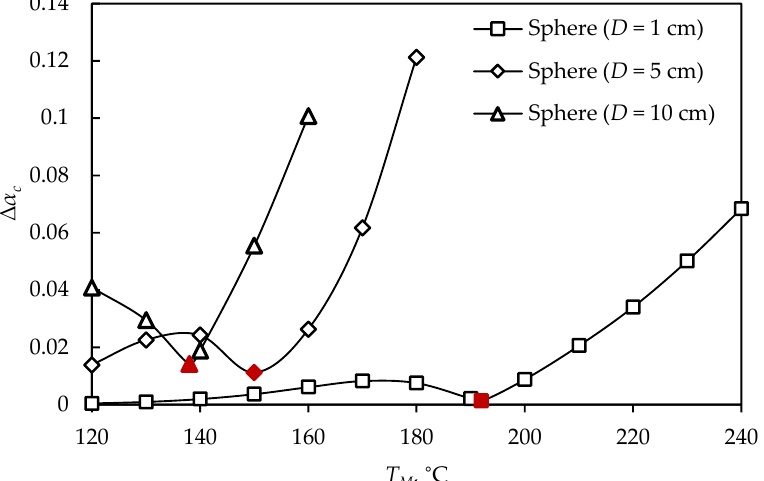
Figure 9. The difference between the maximal and minimal vulcanization degrees of spheres ( D = 1, 5, 10 cm), at different mold